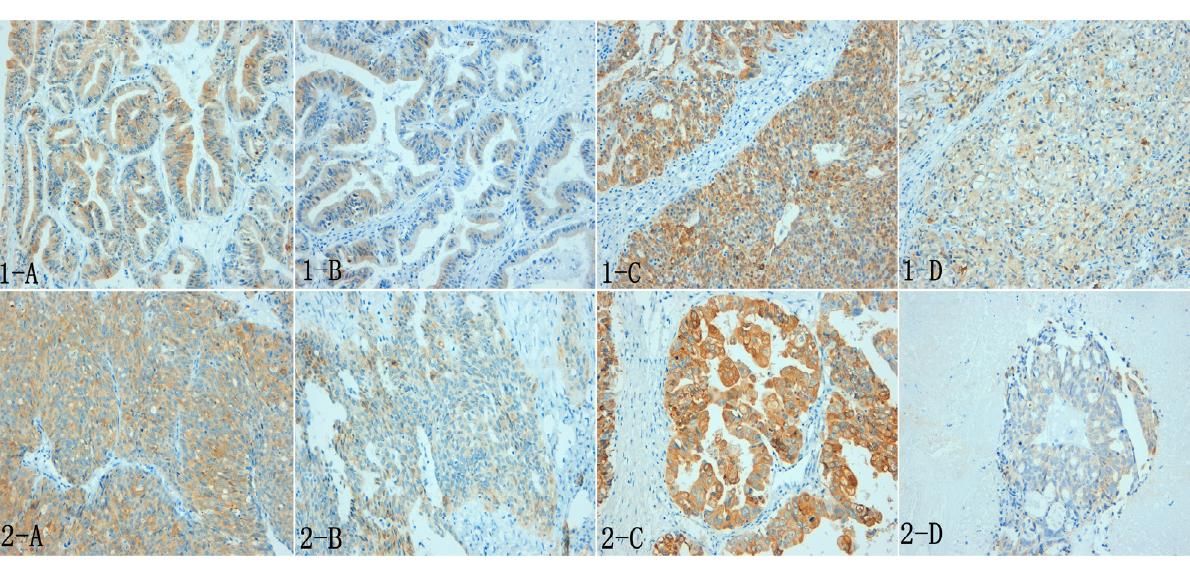
Figure 1. The expression of both MUC1 and the Lewis y antigen in ovarian carcinoma tissues primarily localizes to the cell membrane and cytoplasm [( 1 ) MUC1; ( 2 ) Lewis y antigen; ( A , C ) chemotherapy-resistant group; ( B , D ) chemotherapy-sensitive group]. All images are magnified